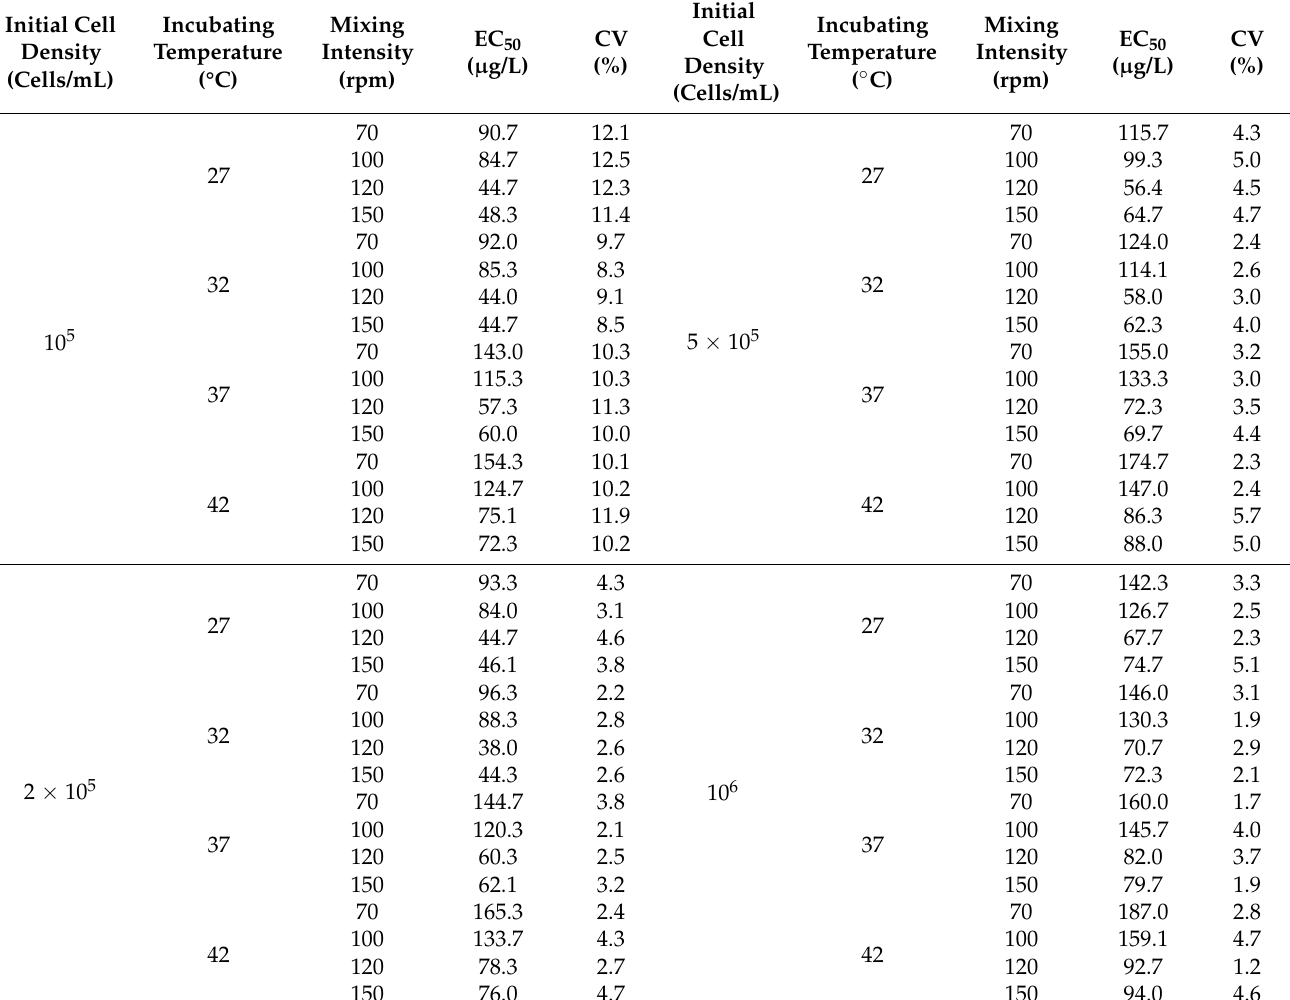
Table 1. Results from optimization for test conditions of SOB toxicity kit (30 min EC 50 for Hg 2+ and CV values, depending on test